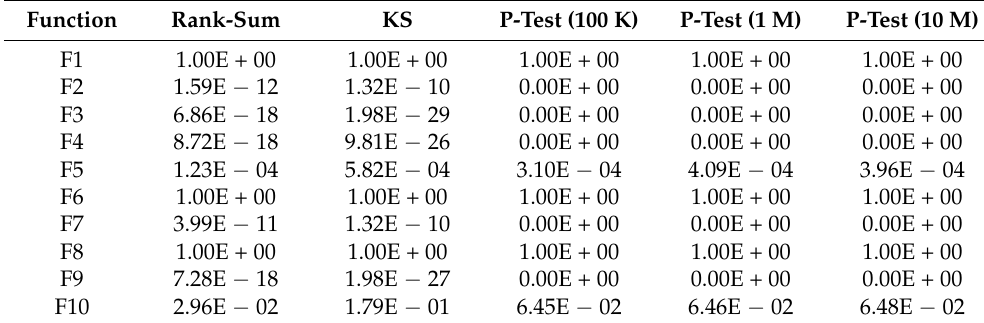
Table 9. The p -values obtained from Wilcoxon rank-sum, KS and permutation tests when comparing SHADE and L-SHADE. When α = 0.05, the results for the tests are consistent except for F10 where KS and P-Test are more conservative than rank-sum.